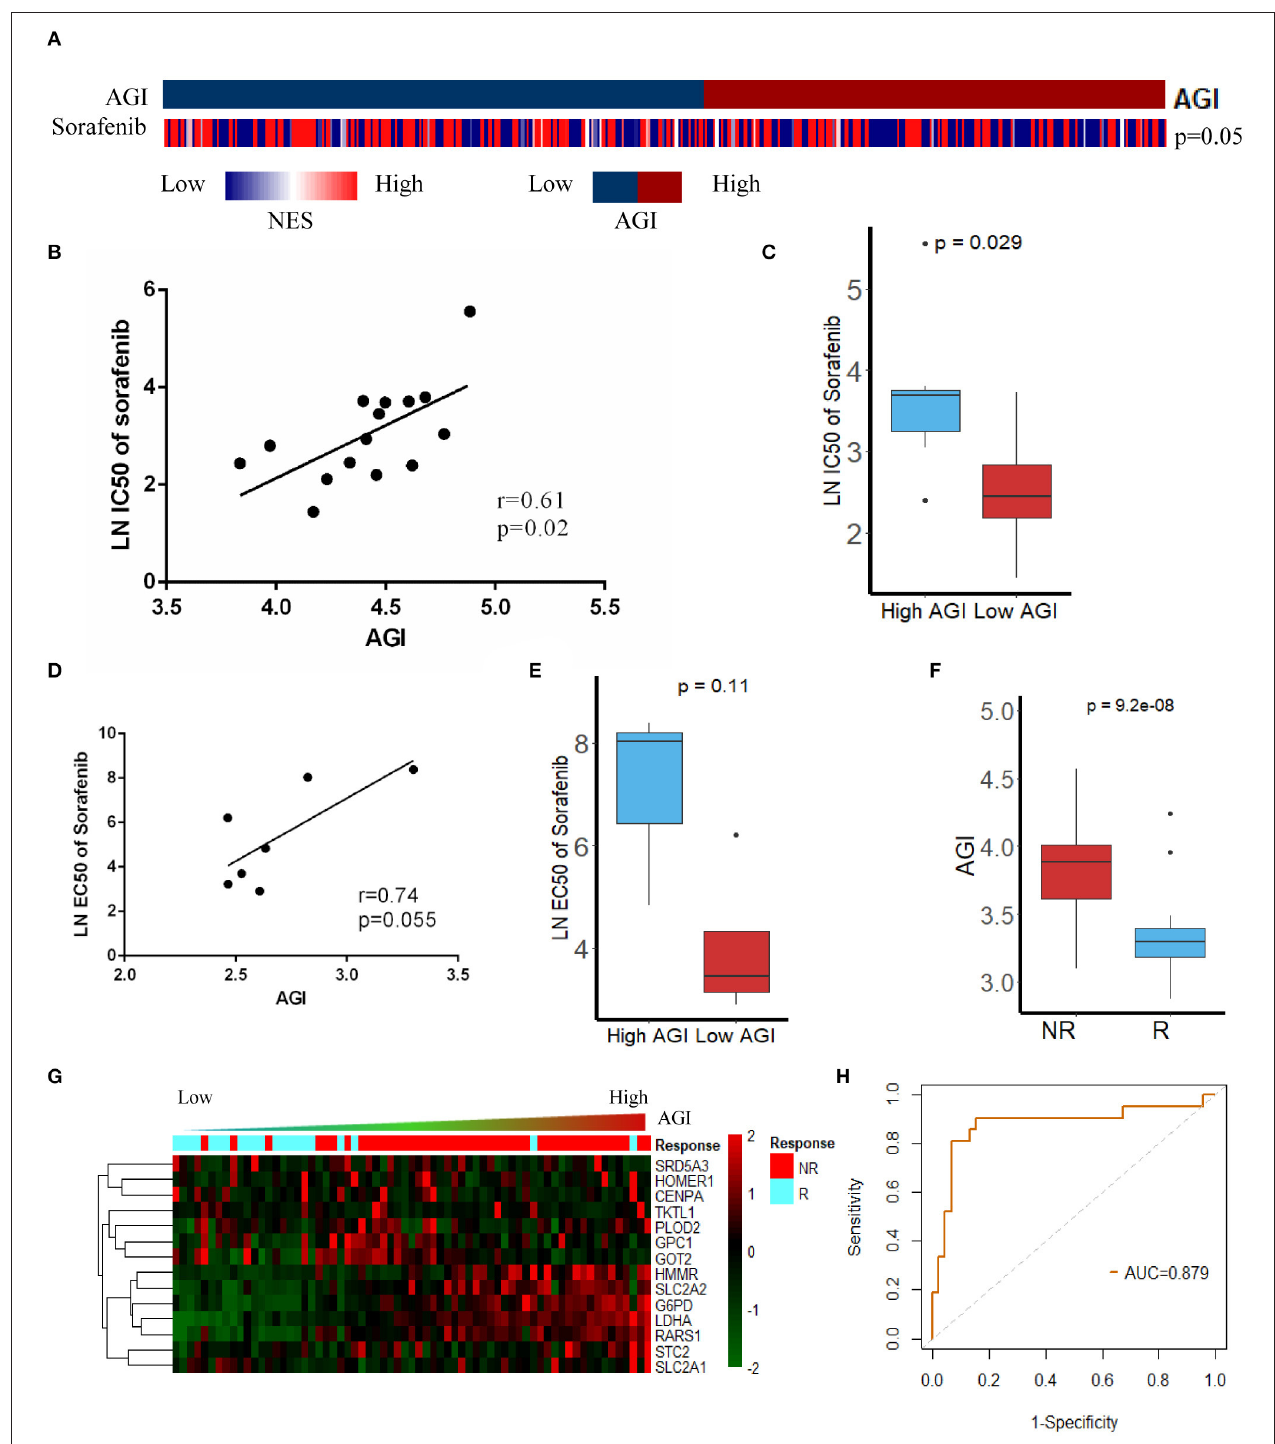
FIGURE 6 | Association between the aerobic glycolysis index (AGI) and Sorafenib resistance. (A) The Gene Set Variation Analysis (GSVA) results showed that the Sorafenib sensitivity signature was enriched in patients with a low AGI. (B) AGI positively was correlated with the IC 50 of Sorafenib in hepatocellular carcinoma (HCC) cell line data from the Genomics of Drug Sensitivity in Cancer (GDSC) database. (C) The IC 50 of Sorafenib in HCC cell line data from the GDSC database with high and low AGIs. (D) AGI positively correlated with the EC 50 of Sorafenib in HCC cell line data from the Cancer Cell Line Encyclopedia (CCLE) database. (E) EC 50 of Sorafenib in HCC cell line data from the CCLE database with high and low AGIs. (F) Patient sensitive to Sorafenib presented significantly low AGI. (G) The heatmap and distribution of the 14 AGI-related gene expression profiles in GSE109211. (H) Receiver operating characteristic (ROC) analysis showed an area under the curve (AUC) of 0.879 for the AGI in predicting the response to Sorafenib.